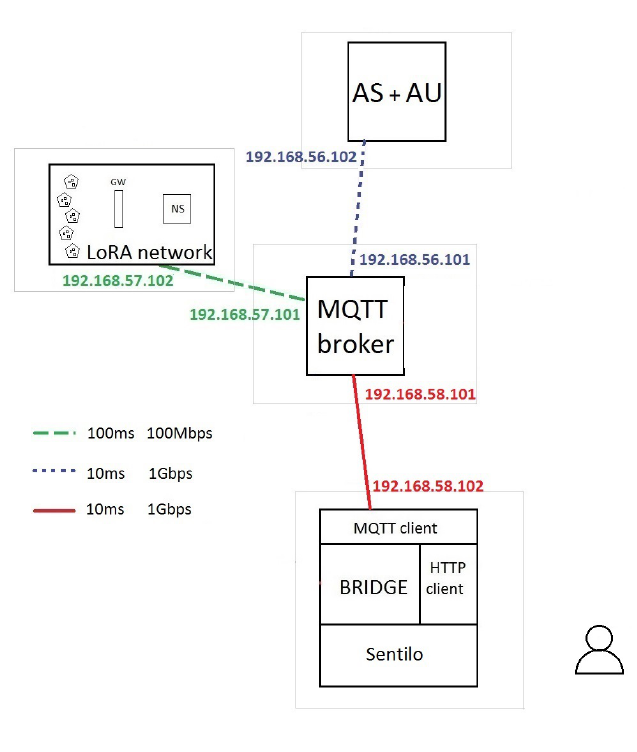
Figure 3. Simulation